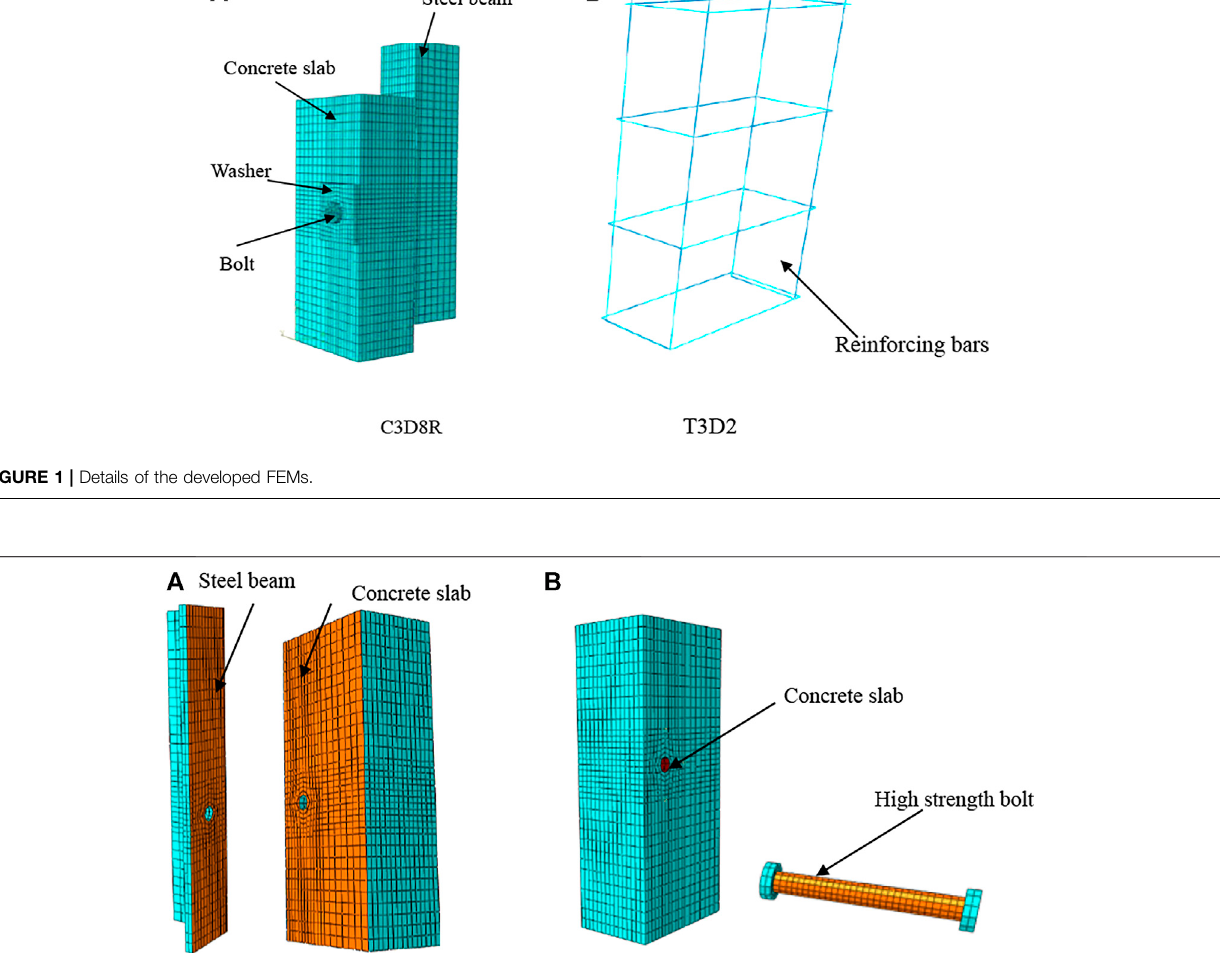
Frontiers in Materials |